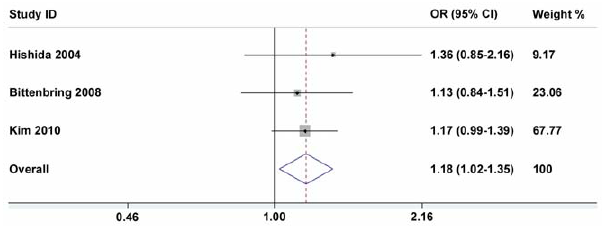
Figure 2. Forest plots of heterozygote model (Arg/Pro vs. Arg/ Arg) in different subgroups. The squares and horizontal lines correspond to OR and 95% CI of specific study, and the area of squares reflects study weight (inverse of the variance). The diamond represents the pooled OR and its 95% CI.